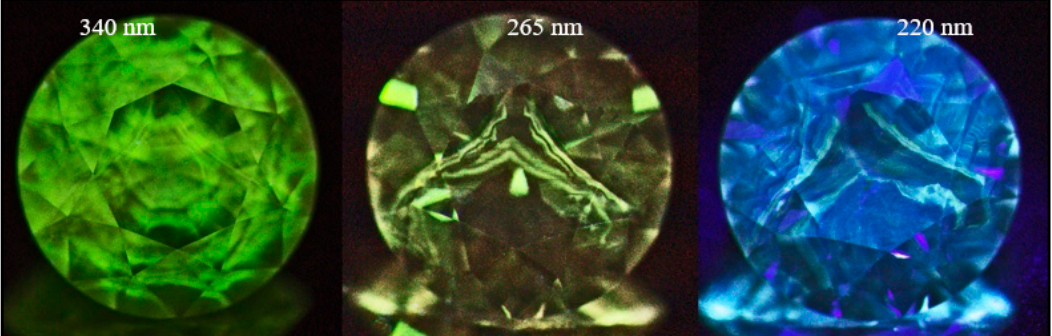
Figure 21. A DR brown hydrogen- and nitrogen-rich type IaA>>B diamond (sample TH 2.622) under three different UV excitations of the DFI system. The images clearly show the typical “Mercedes-star” pattern visible in mixed cuboid-octahedral growth diamonds. In this diamond, the defects were distributed along the cuboid sectors and along the DR slip planes. Along the cuboid sectors, the S3 defect can be detected, while within the deformation-related slip planes the H3 defect is found. At 340 nm, the main defect visible as green PL is the H3 defect while under 265 nm excitation it is the S3 defect; at 220 nm, the N3 defect combined with the S3 center are dominant.